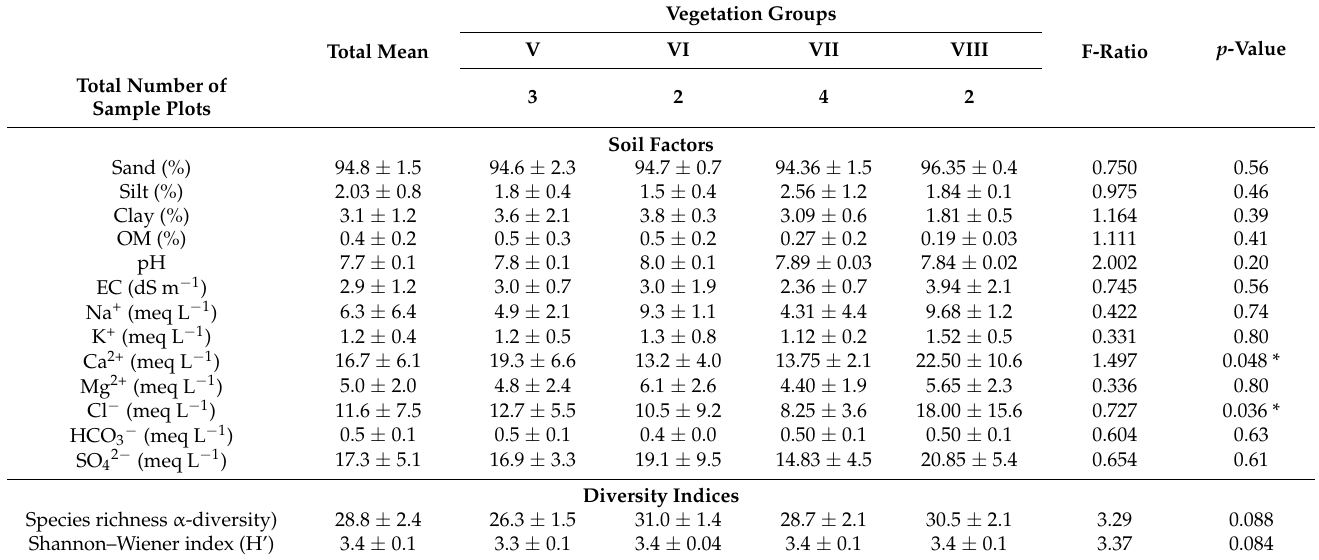
Table 4. Mean values, standard deviations ( ± SD), and ANOVA F-values of the soil variables and diversity indices in the sample plots representing the four vegetation groups obtained by cluster analysis of the Wadi Degla protected area (WD). Abbreviations of soil factors: OM = organic matter, pH = soil reaction, EC = electrical conductivity. Significant differences: * p <